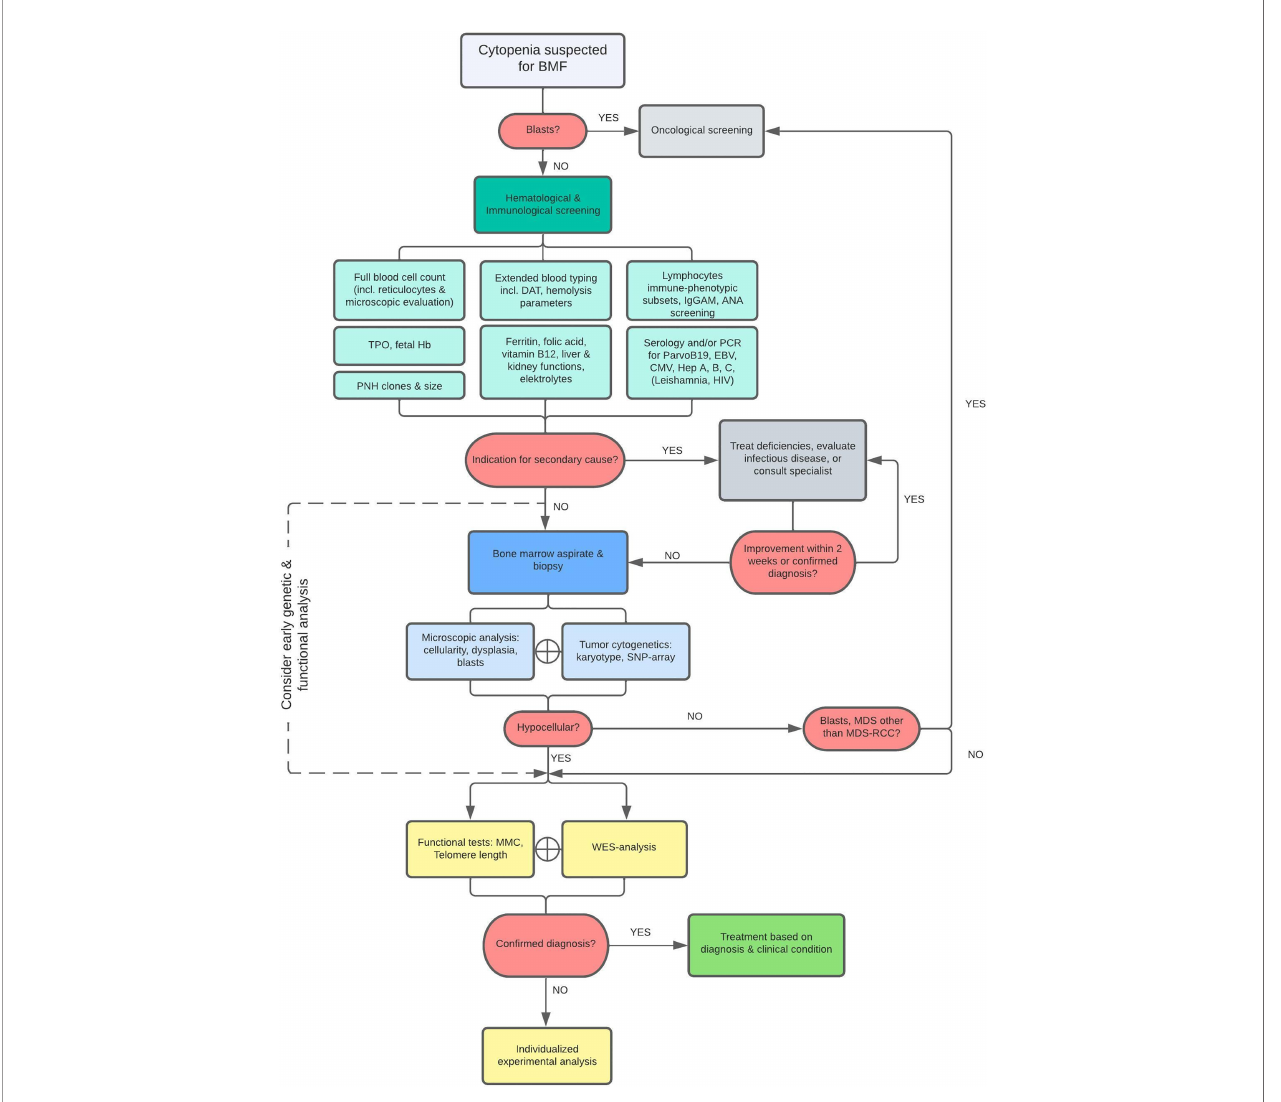
FIGURE 1 | Diagnostic Flowchart. As illustrated, patients with cytopenia suspected for BMF are fi rst screened for leukemia or other malignant disease and if indicated, patients were referred to a pediatric oncological center. Otherwise, patients were examined for speci fi c causes related to secondary BMF. Diagnostics were followed by bone marrow analysis within 2-3 weeks when no cause for cytopenia was found or no improvement was achieved after initiation of treatment. Bone marrow aspirate and biopsy are evaluated and additionally cytogenetically assessed by karyotyping and SNP-array analysis to detect chromosomal abnormalities. Finally, a BMF fi lter-based WES and functional analyses are performed in all patients. The scope of WES was expanded when no mutations were found after the primary analysis if a constitutional origin of BMF was still highly suspected (e.g., IEOI- fi lter, Trio-WES,